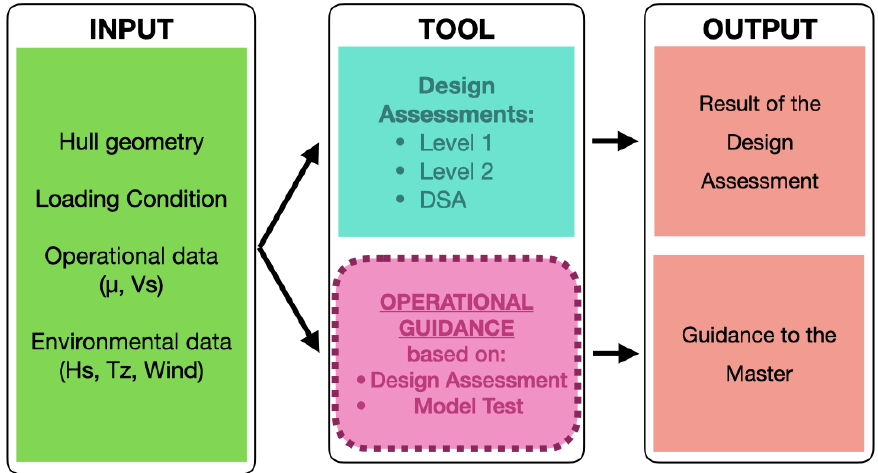
Figure 3. Scheme of the logical concept for Operational Guidance